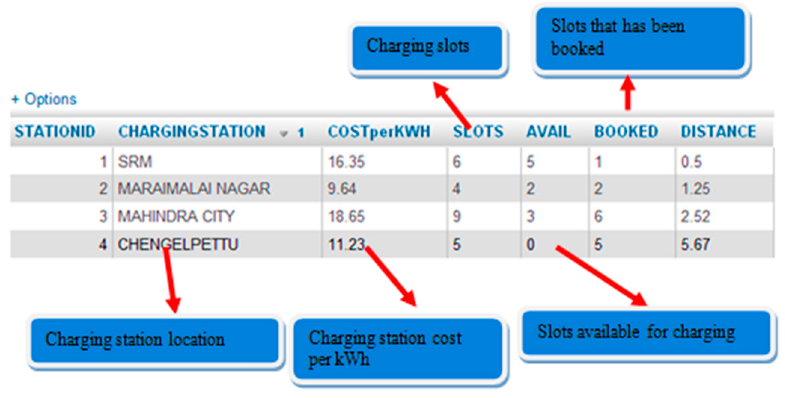
Figure 14. Database of charging stations.